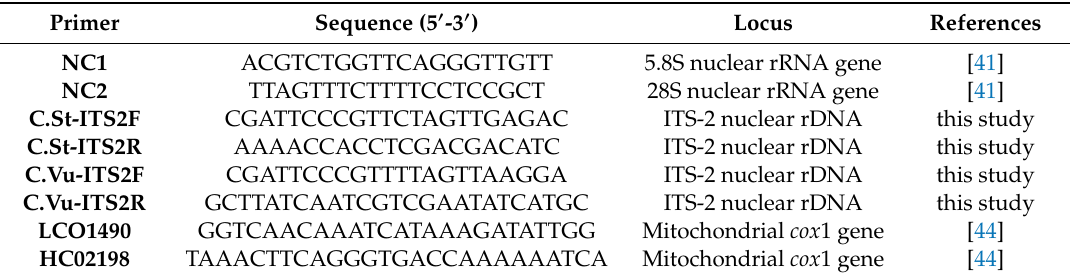
Table 1. The primers and their loci used in PCR tests to identify the presence or absence of Crenosoma striatum in